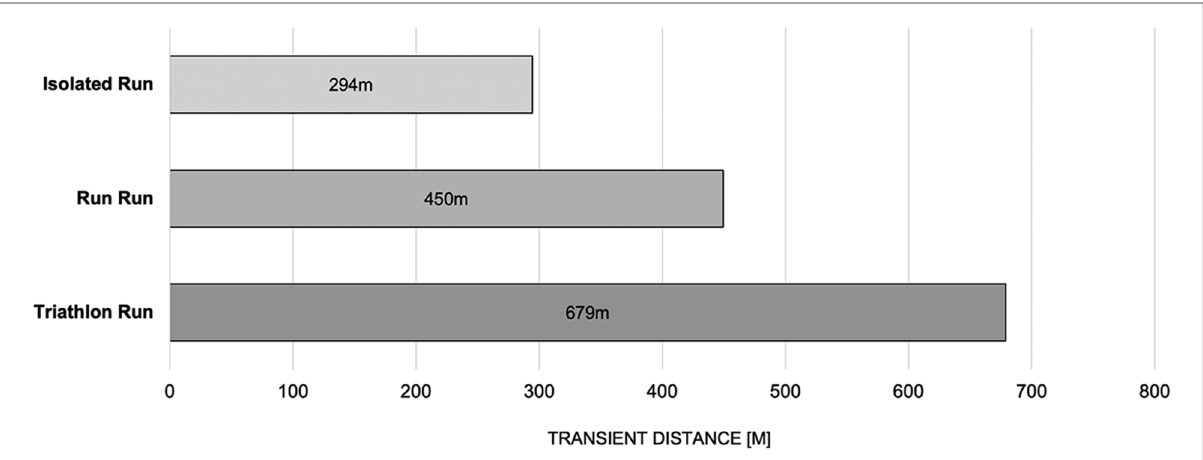
FIGURE 8 Overview of the different distances that were covered to fi nish the transient process at the initial stage of a run. Only sessions with a measured transient effect are included in the